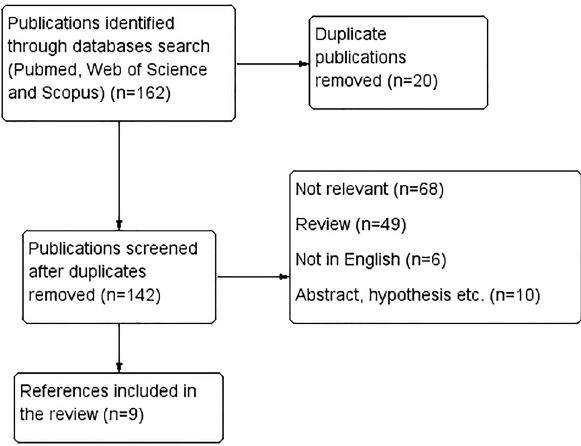
Figure 1: Flow diagramof studies includedin